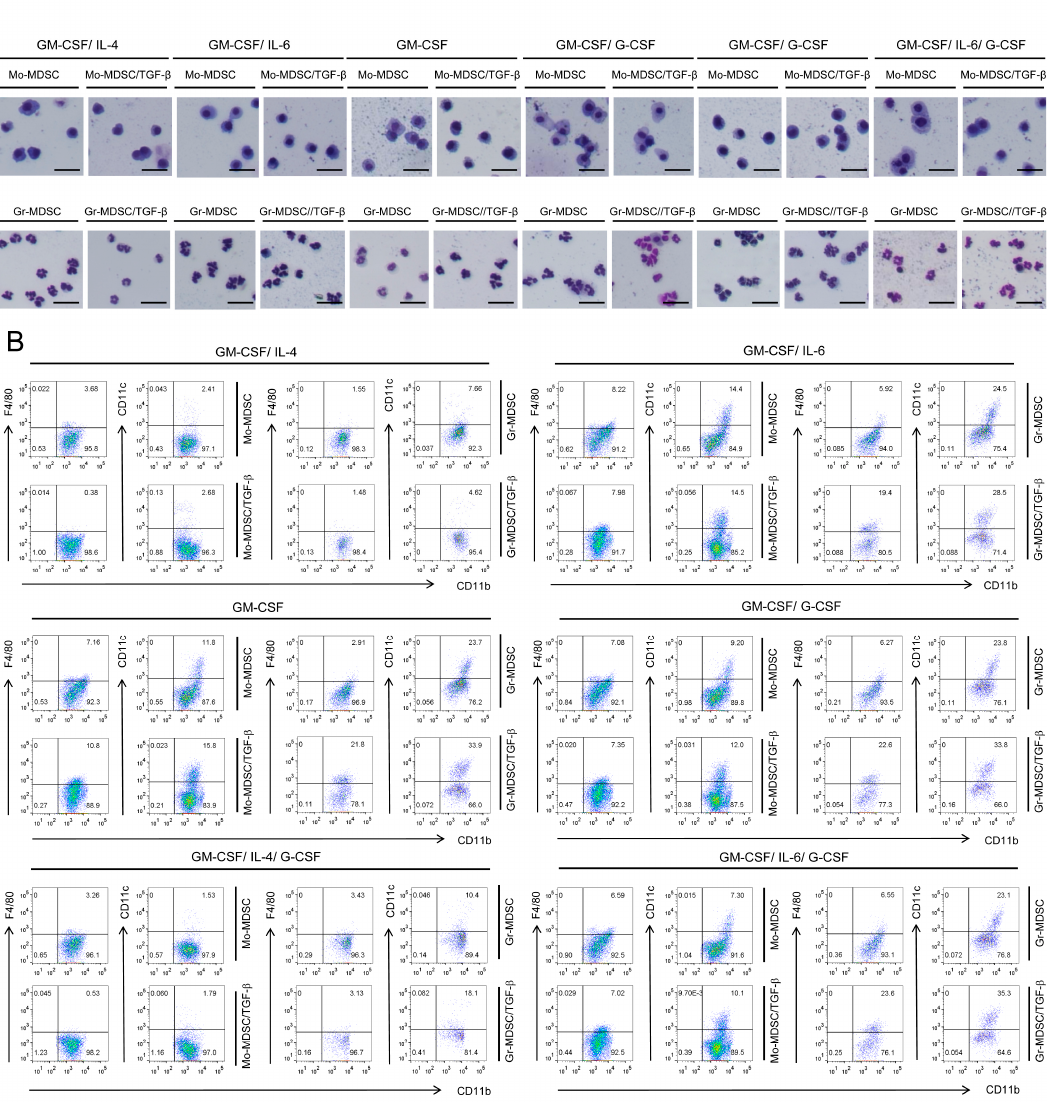
Figure 2. Microscopic phenotype and mature marker expression of the generated MDSCs. ( A ) Wright-Giemsa staining of MDSCs induced by six different cytokine combinations in the presence/absence of TGF- β ; The scale bars at the bottom right of images indicate 100 μ m. ( B ) Flow cytometry analysis of F4/80 (a marker of mature macrophages) and CD11c (a marker of mature dendritic cells) expression by bone marrow-derived MDSCs differentiated in the presence/absence of TGF- β . GM-CSF, granulocyte-macrophage colony stimulating factor; IL-4, interleukin-4; IL-6, interlukin-6; G-CSF, granulocyte colony stimulating factor; Data are representative of two independent experiments ( A ) or three independent experiments in triplicate (B).